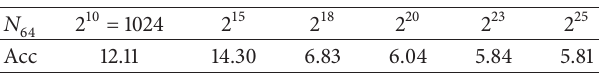
Table 2: The results of experiments (data are transferred through one 32-bit ACP high-performance port and 𝜂 = 32 ).